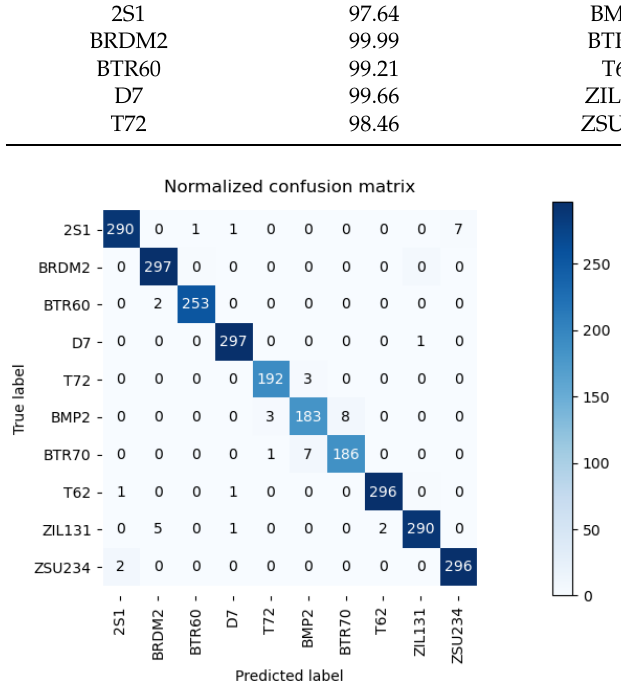
Figure 9. Validation set confusion matrix for SAR-BagNet.